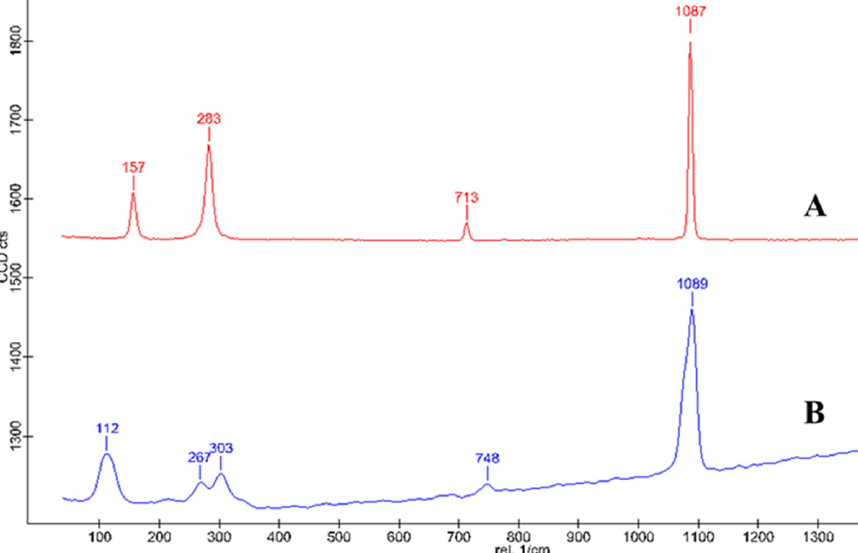
Figure 9. Raman spectrum of the formed crystal. Note—A: crystals in the control group; B: Crystals in the experimental group.